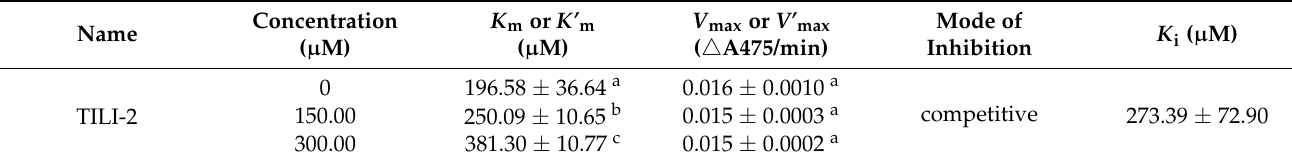
Table 2. Effect of TILI-2 on kinetic constants of tyrosinase monophenolase activity.